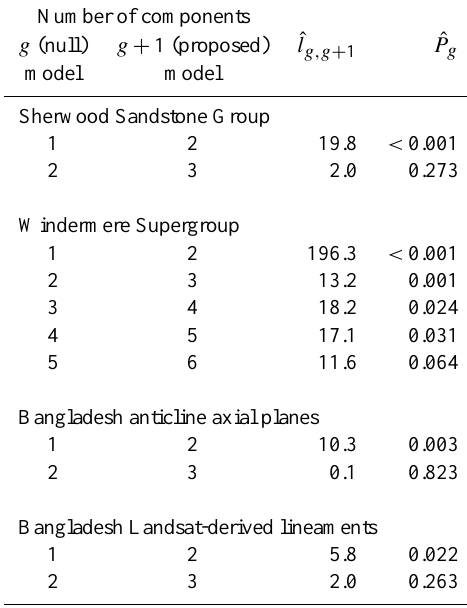
Table 1. Selection of a mixture of von Mises (MVM) distributions. Number of components